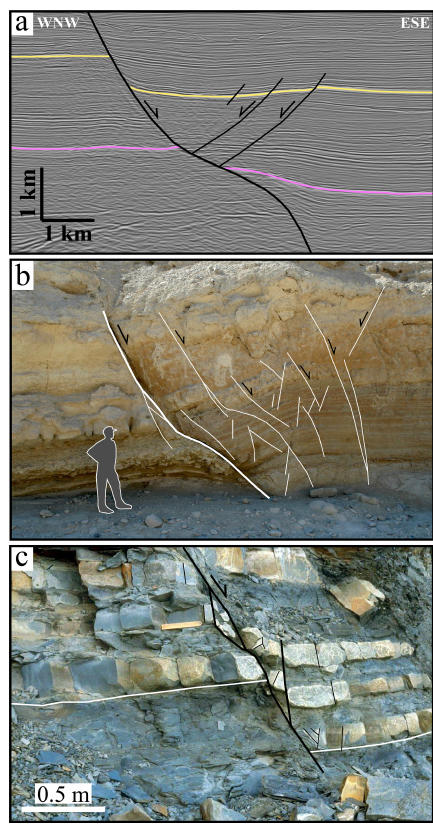
Figure 6. (a) Interpreted seismic section of a nonplanar fault and associated hangingwall deformation in the Taranaki Basin, offshore west of North Island/Te Ika-a-M¯aui, New Zealand. Deformation arises from movement on a fault bend produced by twisting and segmentation of an upward propagating fault (modified after Giba et al., 2012). (b) Outcrop example of a rollover anticline associ- ated with a fault surface which has a sigmoidal shape from Wadi Matulla, Sinai, Egypt (modified from Fossen, 2016). (c) Outcrop example of a fault with 0.5m throw contained within the Liassic limestone–shale sequence of Kilve, Somerset, UK, showing normal drag arising from a convex upward bend (and fault steepening). See text for more